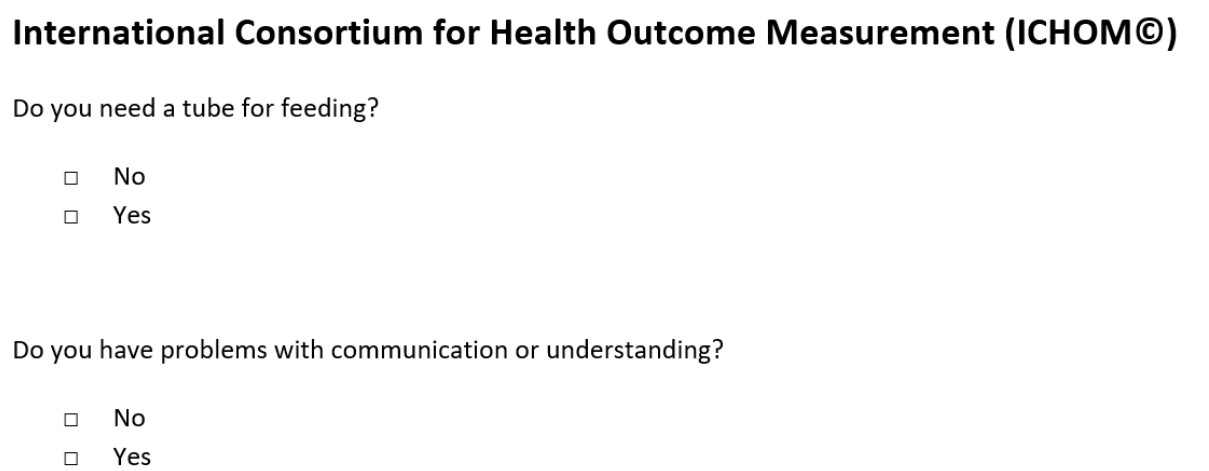
Figure A1. The 15 questions used in the PROM. Table A1. Trial Cohort Demographics for Completers, Non-Completers and Non-Responders.